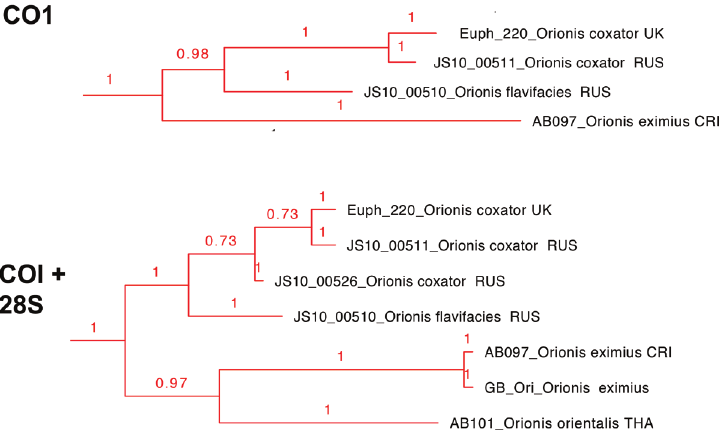
Figure 2. Extract from Bayesian phylogeny of Perilitini: relationships of Orionis species based on CO1 and CO1+28S analyses. Numbers on branches are posterior